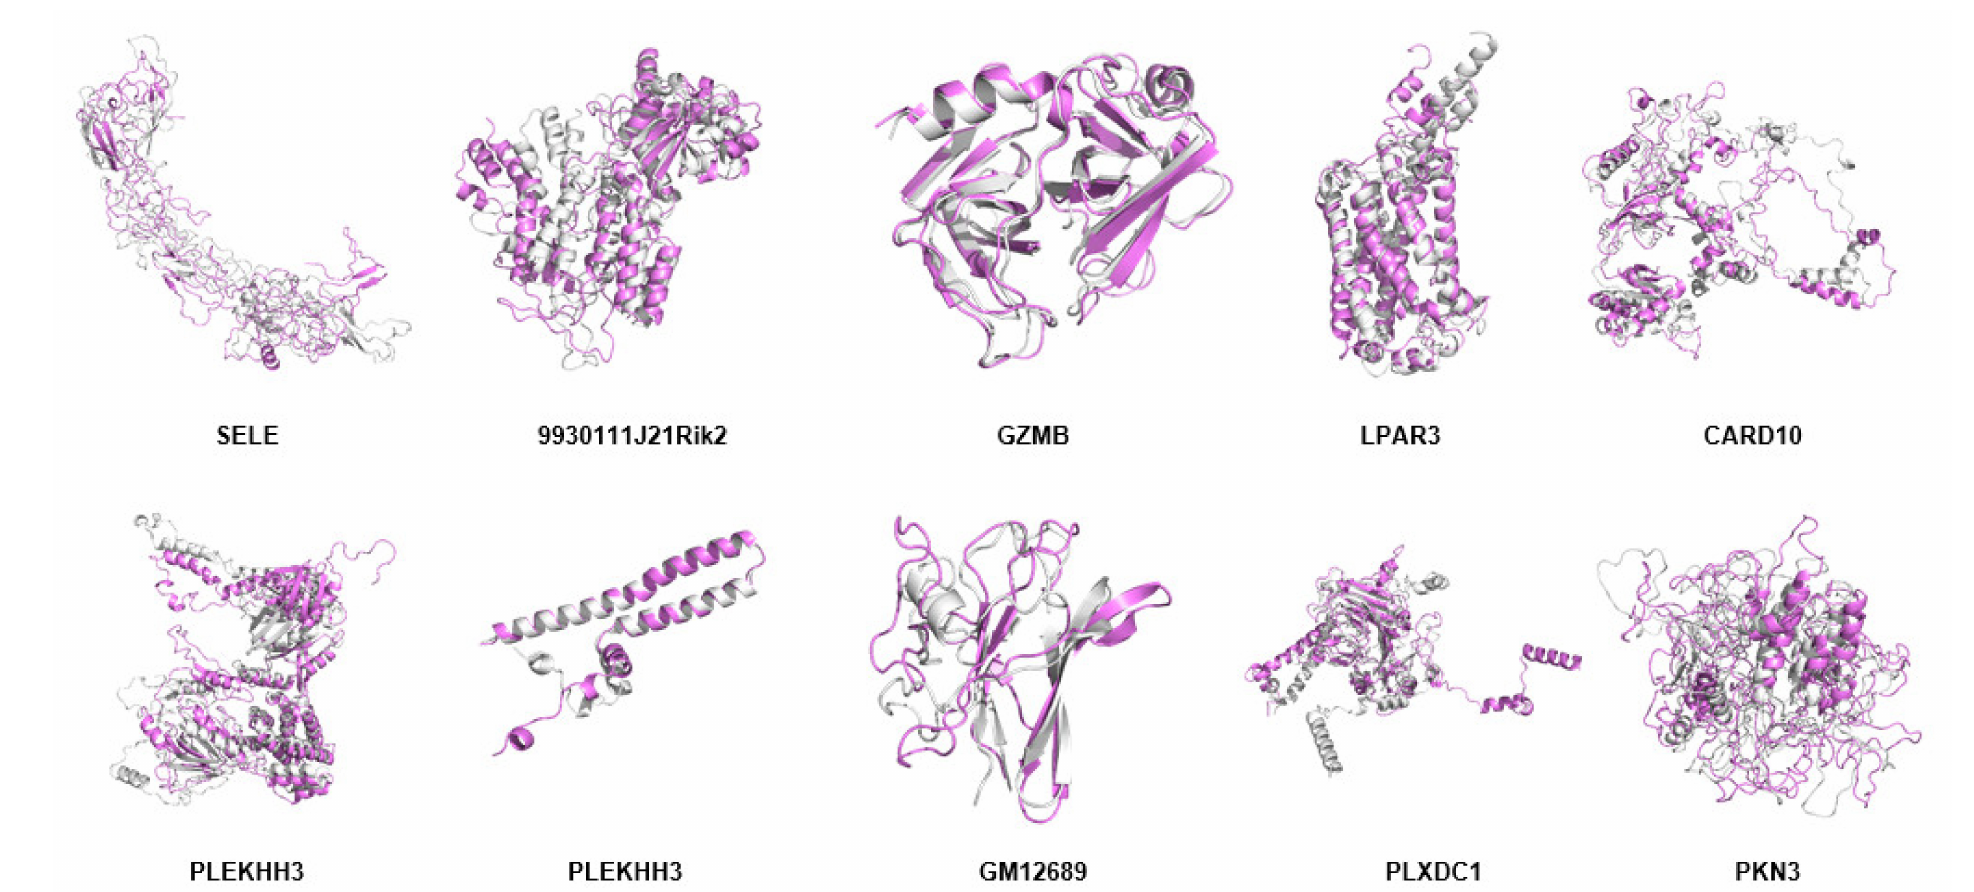
Figure 11. Superposition of the modeled structure (gray) and MD-optimized protein structure (violet) of hub proteins, including SELE, 9930111J21RIK2, GZMB, LPAR3, CARD10, PLEKHH3, HIGD1B, GM12689, PLXDC1, and PKN3. Figures were generated using the Pymol